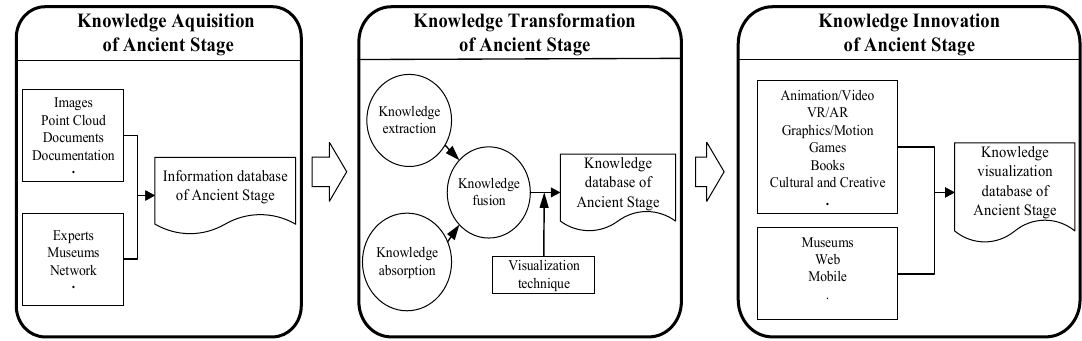
Figure 3. Knowledge visualization model of ancient stage.